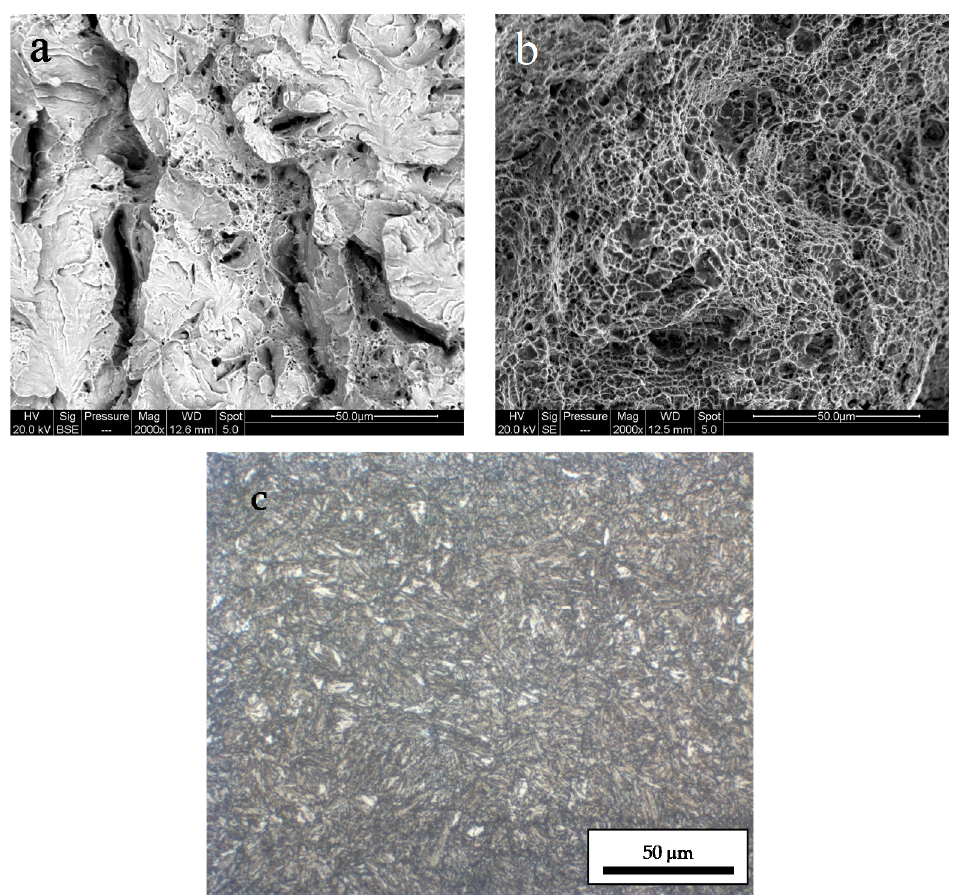
Figure 5. ( a ) Brittle cleavage texture in the crack surface of the M50 class 10.9 bolt shown in Figure 1; ( b ) ductile collapse texture in the tensile specimens extracted from the shaft of the same bolt; ( c ) microstructure of the bolt in the center of the shaft diameter.